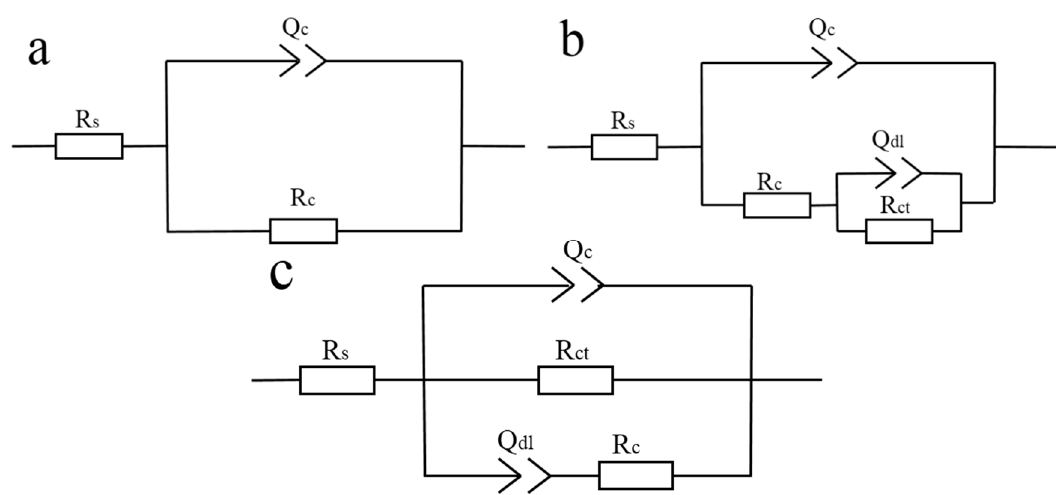
Figure 12. Equivalent circuit for ( a ) WPU coating, ( b ) MGO / WPU composite coating and ( c ) MGO-PTFE / WPU composite coating.